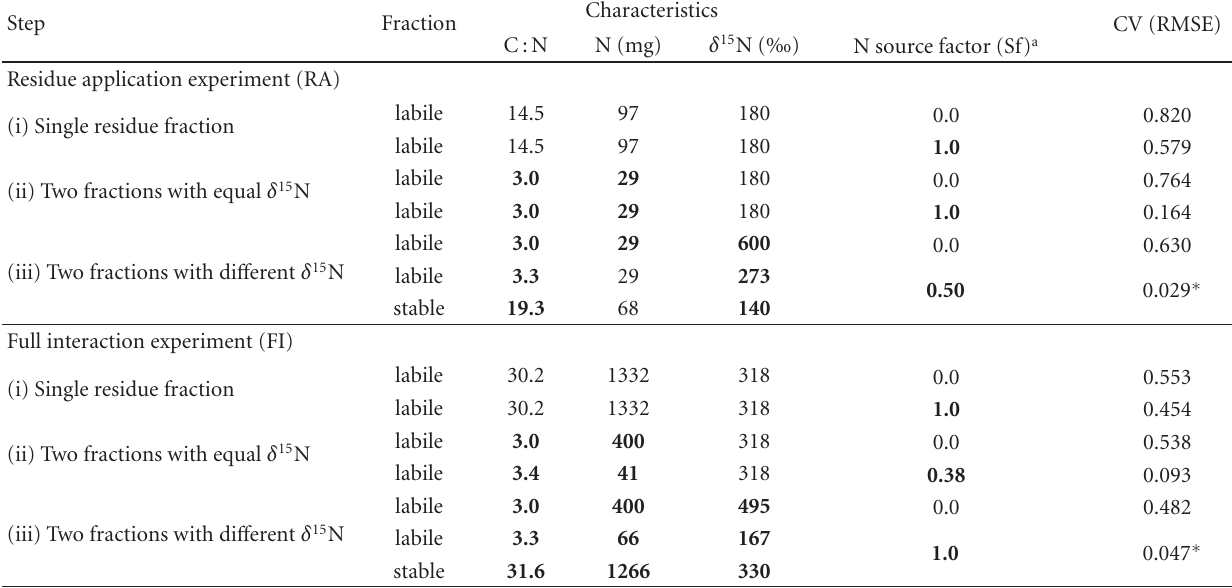
Table 3: Simulation steps, optimal parameter values and performance of the residue decomposition model. Values indicated in bold were obtained through model optimisation; other values were fixed in the respective simulation steps. Residue parameter values are for labile fraction, except for the final simulation step for which values are given for both labile and stable fraction. For CV (RMSE), asterisk ( ∗ ) indicates statistically significant fit between observed and simulated δ 15 N values of the N recipient plant ( < 0.05). Characteristics Step Fraction